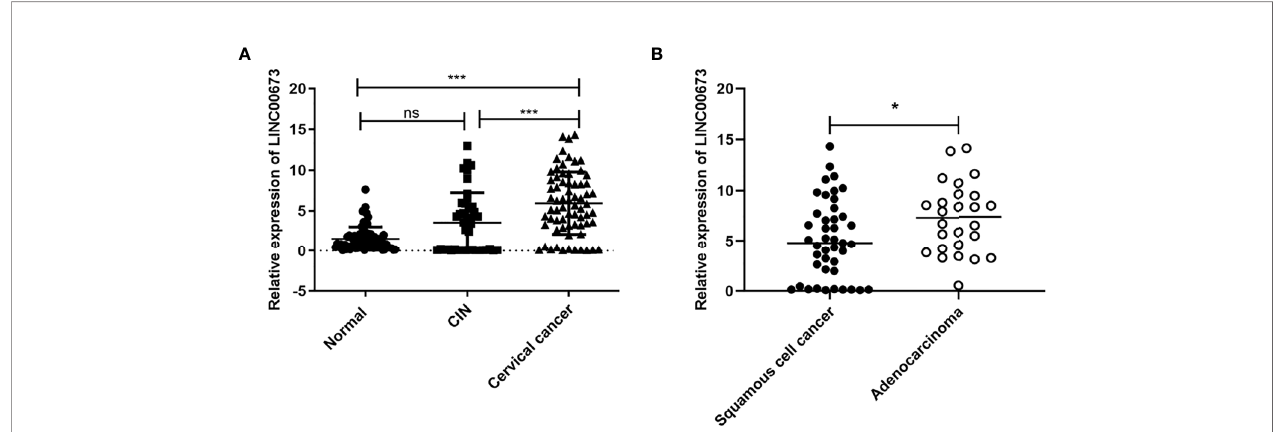
FIGURE 1 | LINC00673 is expressed at different levels in different populations. (A) RT-qPCR shows that the level of LINC00673 was gradually increased in serum from healthy controls (n = 71), CIN patients (n = 42), and cervical cancer patients (n = 69). (B) LINC00673 in serum was signi fi cantly lower in squamous cell carcinoma patients (n = 43) than in adenocarcinoma patients (n = 26). * P < 0.05, *** P < 0.001. Student ’ s t -test. ns, not statistically signi fi